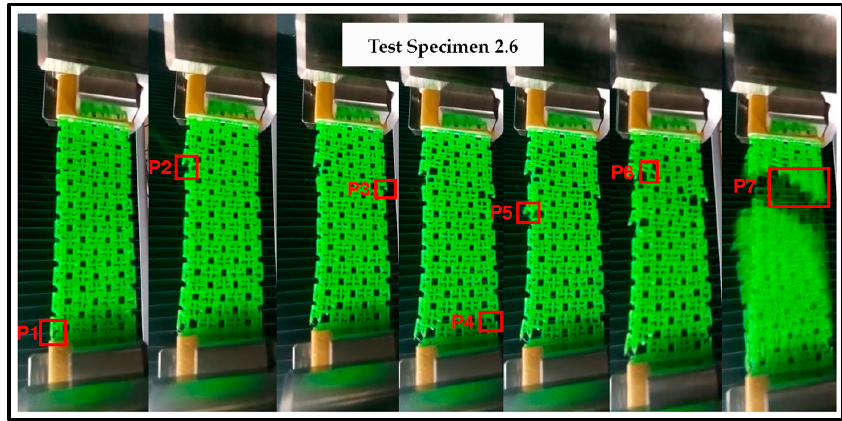
Figure 4. Random breakage sequence of the specimen 2.6.